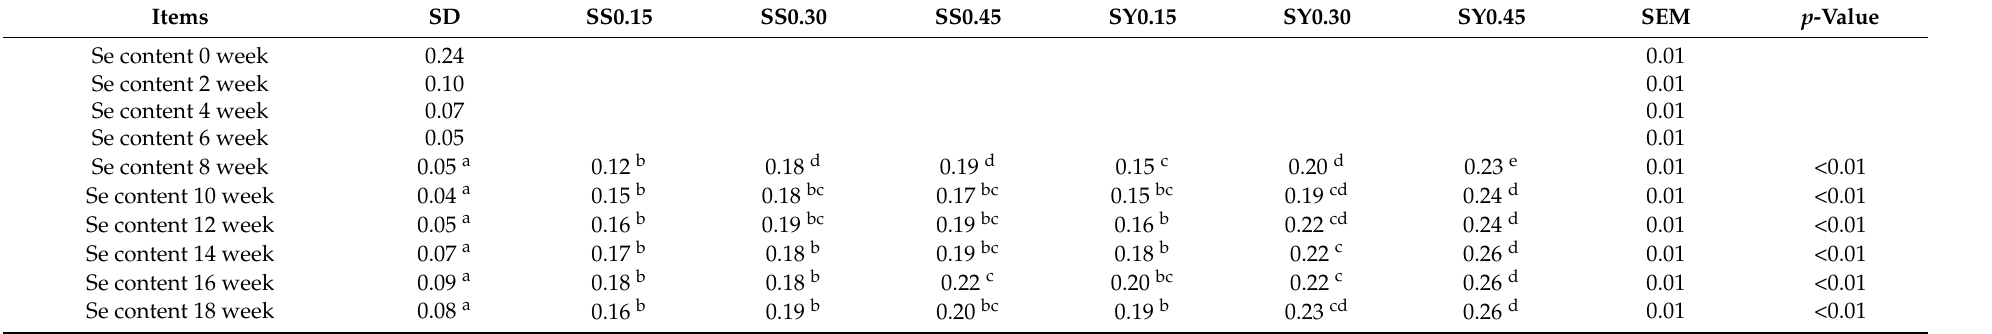
Table 3. Selenium content of plasma during the whole experiment period (experimental weeks 0–18).